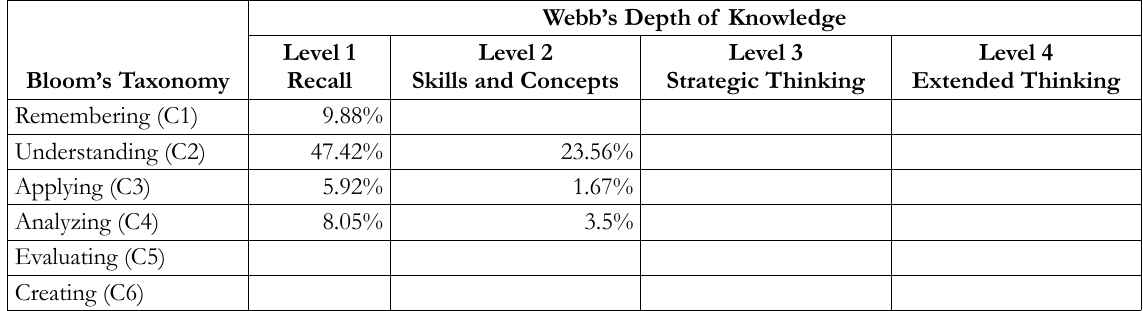
Table 4. Students’ thinking skills based on the Polymer Concept Test using Hess’ Cognitive Rigor